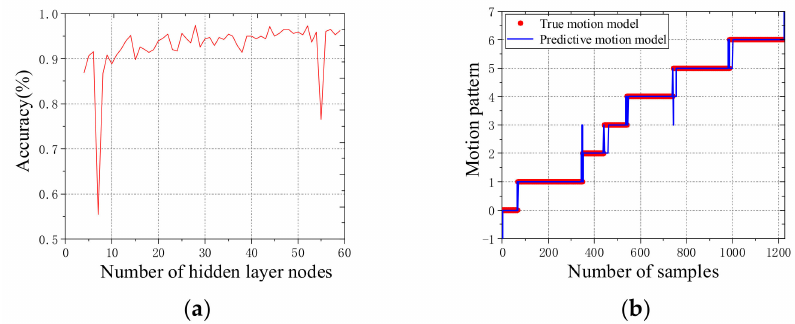
Figure 7. Recognition accuracy rate using a multilayer perceptron classifier. ( a ) Model accuracy rate under cross validation. ( b ) Comparison of the true value of the validation set and the classification result.